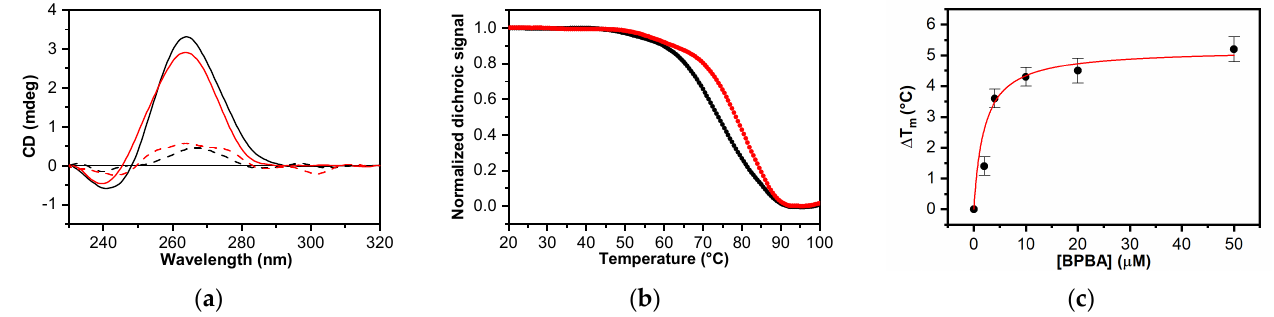
Figure 2. ( a ) CD spectra of TERRA G4 in the absence (black line) and presence (red line) of 10 molar equiv of BPBA recorded at 20 and 100 °C (solid and dashed lines, respectively); ( b ) CD melting profiles of TERRA G4 in the absence and presence (black and red dots, respectively) of 10 molar equiv of BPBA recorded at 1 °C/min heating rate; ( c ) CD stabilization curve for TERRA G4 with BPBA .